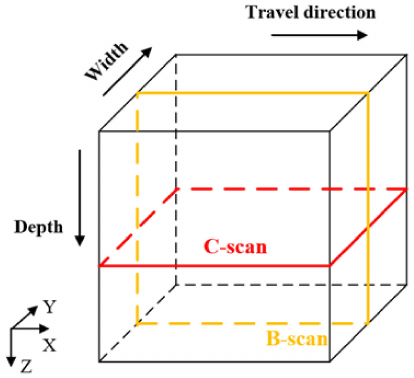
Figure 2. Orthogonal slice planes (B-, C-scan) of 3D GPR